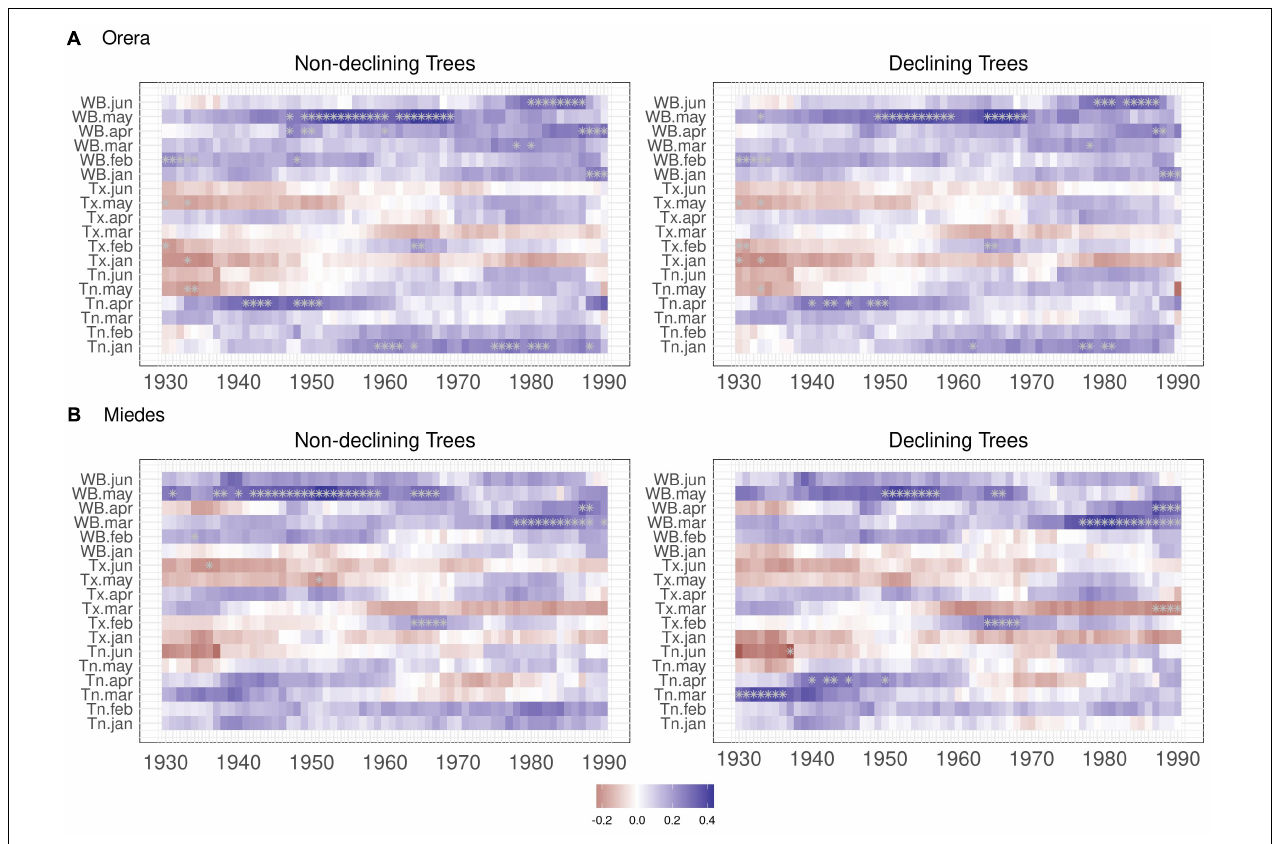
FIGURE 3 | Moving climate-growth correlations of ND and D trees in the (A) Orera and (B) Miedes study sites. Plots show selected climate variables and their relationships with RWI considering 30-year moving intervals that shifted every year from 1930 to 2019. Values are plotted for the first year of each 30-year interval. Asterisks indicate significant ( p < 0.05)